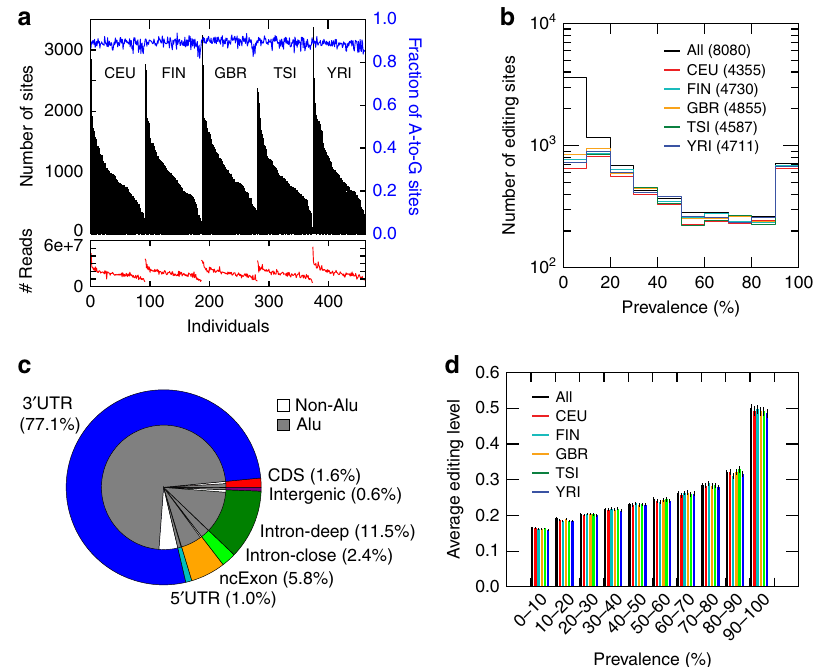
Fig. 1 Pro fi le of A-to-I editing in human populations. a The total number of RNA-DNA mismatched sites (black bars) identi fi ed in RNA-Seq data of each individual in each population, along with the fraction of A-to-G editing sites among all sites (blue), and the number of uniquely mapped reads per sample (red). Individuals are grouped by population fi rst and then sorted by the total number of sites. a Prevalence of predicted A-to-I editing sites in each population. Prevalence of an editing site in a population is de fi ned as % of individuals with the site edited among all individuals with read coverage ≥ 10 (i.e., testable sites). The total number of unique A-to-I editing sites in each population or in the union of all individuals is included in brackets. c Genomic distribution of predicted A-to-I editing sites. Intron-close: intronic editing sites within 300 nts from exon-intron boundaries; CDS: coding sequence; UTR: untranslated region; Intron-deep: intronic editing sites more than 300 nts away from exon-intron boundaries; ncExon: exons in non-coding transcripts. d Average editing level per population for editing sites in different prevalence groups (number of editing sites in each group is shown in b ). Error